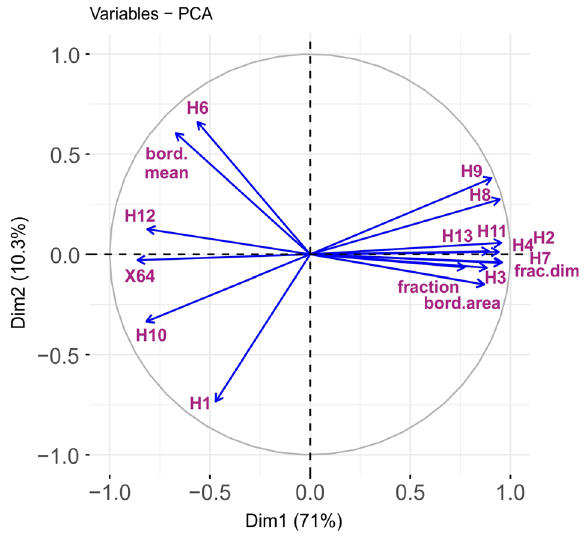
Figure 3. Input textural features and their contributions to the principal